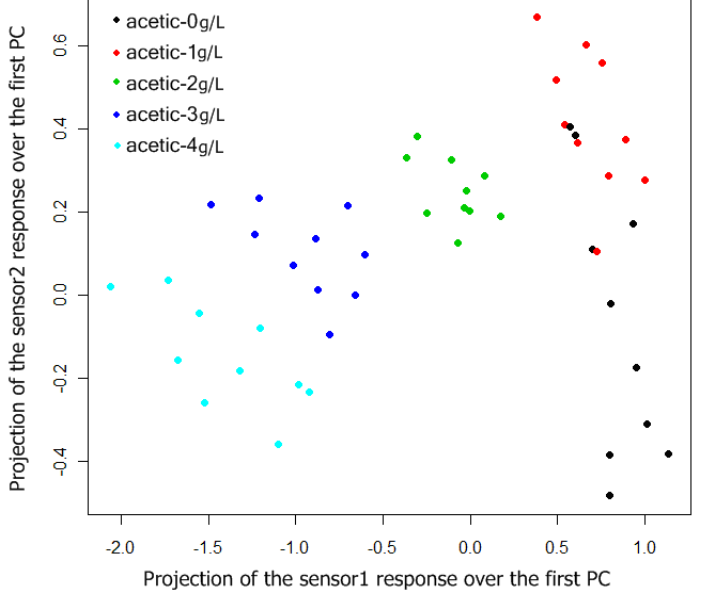
Figure 7. Two dimensional representation of the classification problem.